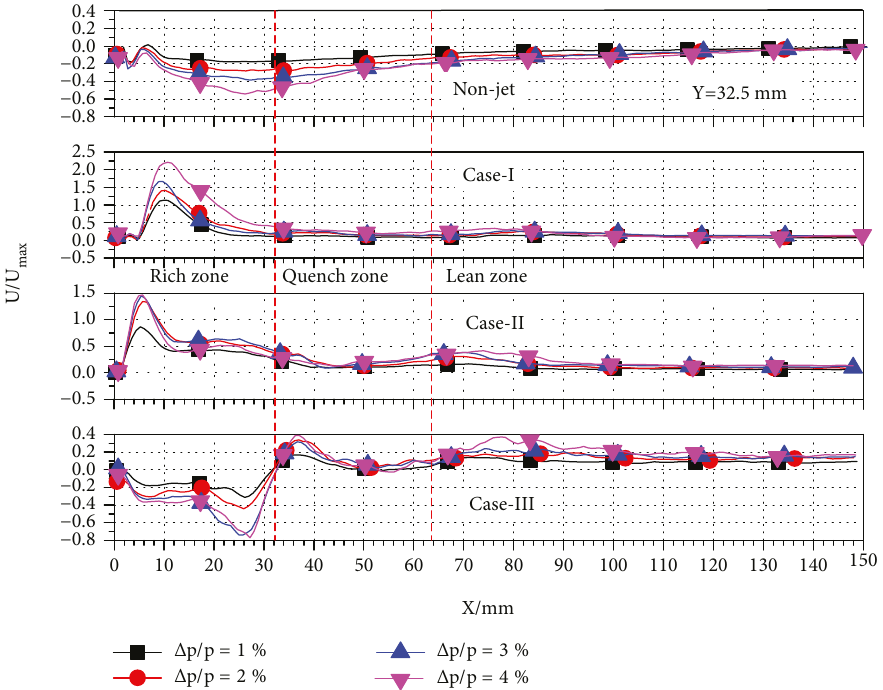
Figure 10: Axial velocity along the X direction at Y = 32 5mm on the Z = − 15 5 mm